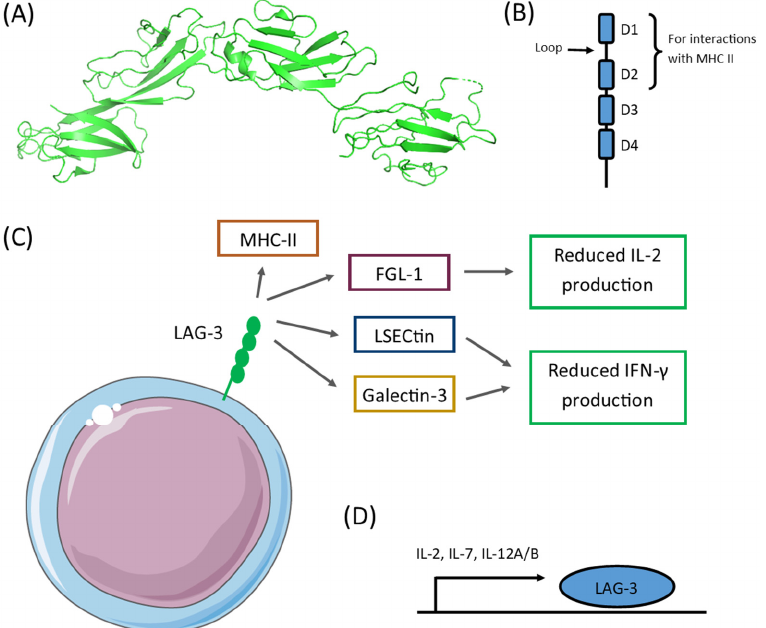
Figure 1. ( A ) Molecular structure of LAG-3 D1-D4 domains derived from PDB 7TZG; ( B ) LAG-3 membrane protein is composed of D1-D4 Ig domains, D1, D2 and loop are required for the interactions with MHC-II; ( C ) Lymphocytes interactions via LAG-3 with MHC-II, FGL-1, LSECtin, Galectin-3, which leads to the reduced production of IL-2 and IFN- γ ; ( D ) Expression of LAG-3 regulated by IL-2, IL-7 and IL-12A/B.